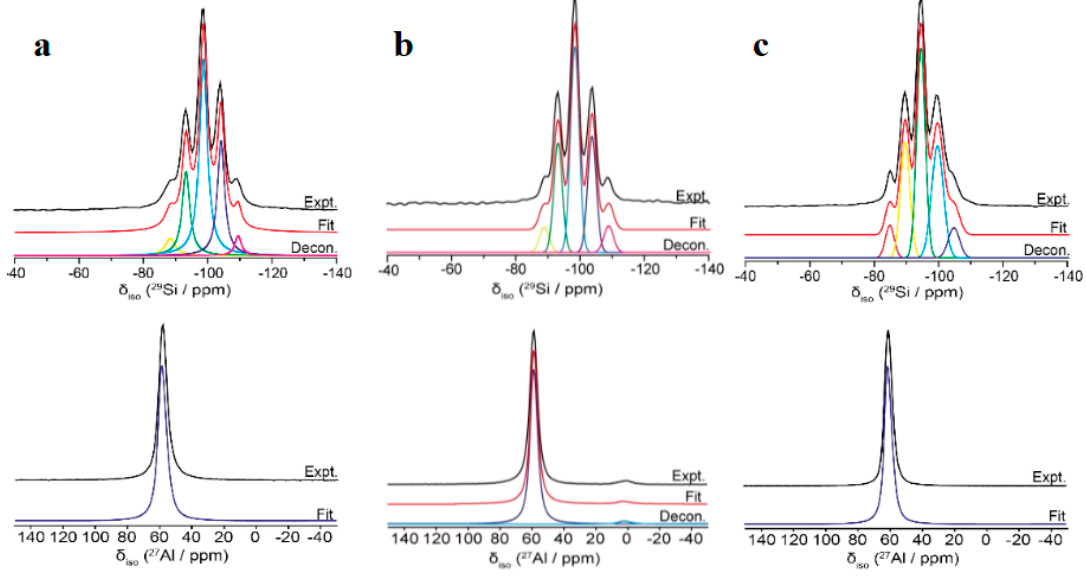
Figure 7. 29 Si MAS NMR data ( top ) and 27 Al MAS NMR data ( bottom ) of ( a ) NaY-LDX; ( b ) NaY-SW and ( c ) commercial